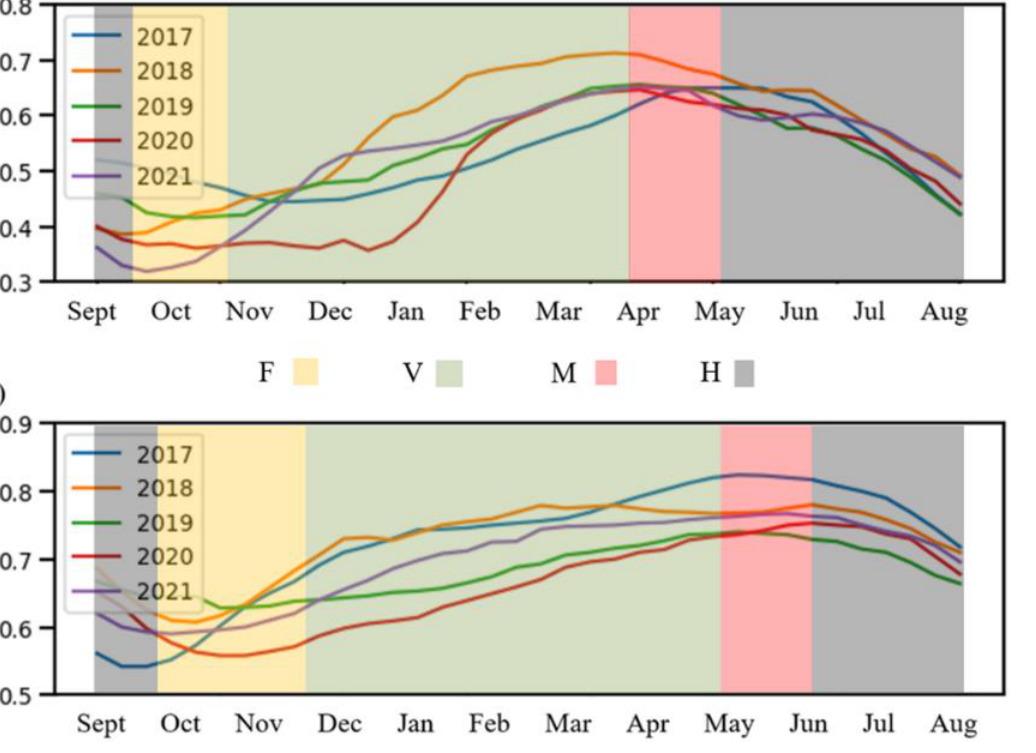
Table 3. Results of the Tukey-HSD test for the Bundaberg and Renmark avocado farms. Bundaberg Farm Difference be- tween Stages